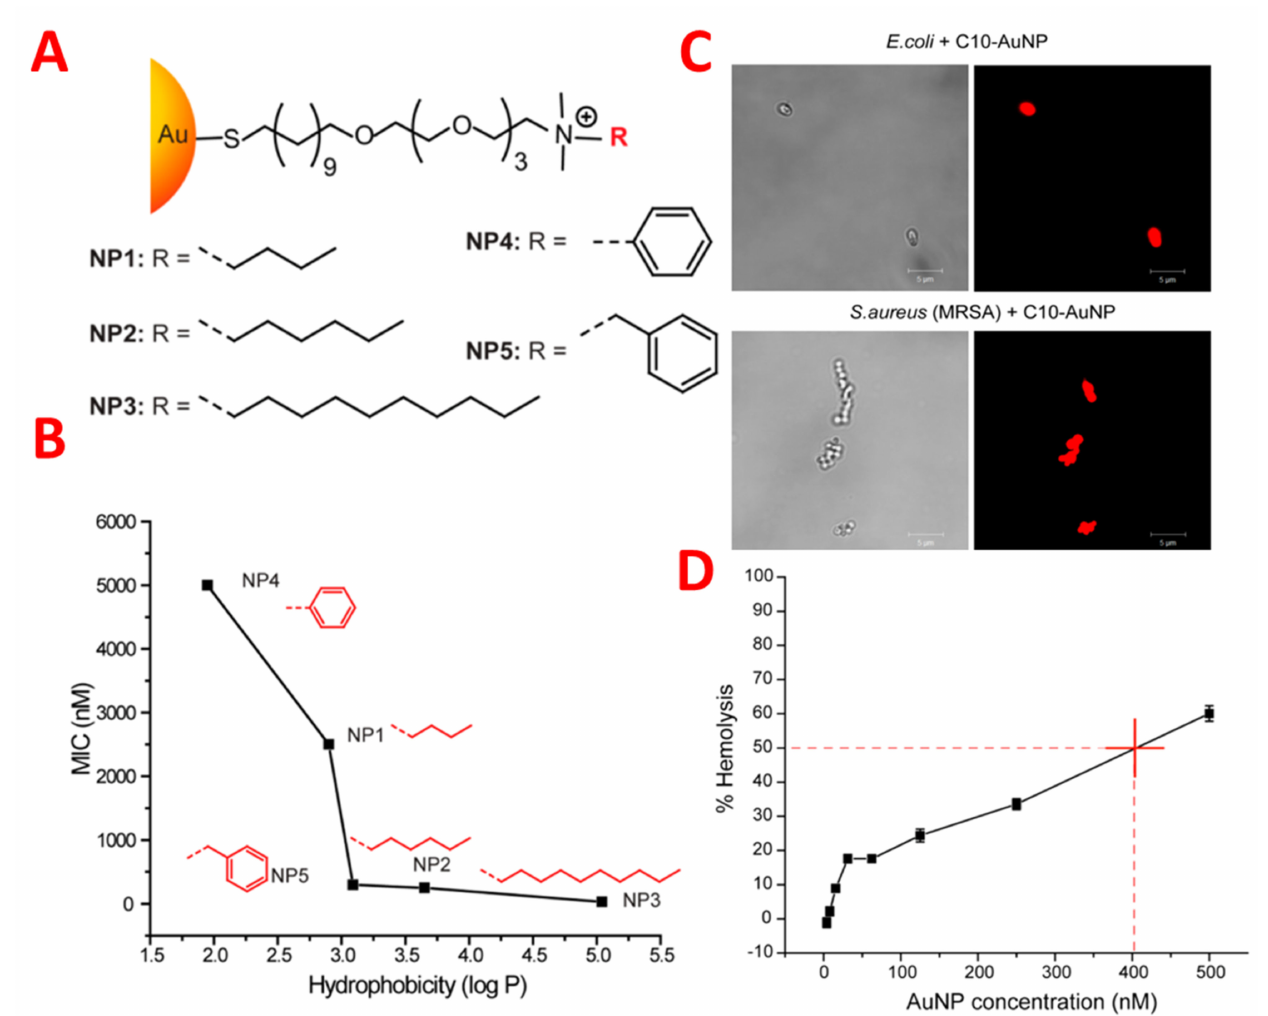
Figure 4. ( A ) Molecular structures of functional ligands on AuNPs. ( B ) MIC values (nM) of AuNPs bearing different hydrophobic surface ligands against laboratory E. coli DH5R. Log P represents the calculated hydrophobic values of the end groups. ( C ) PI staining showing NP 3 (C10-AuNP)-induced bacterial cell membrane damage. Scale bar is 5 µ m. ( D ) Hemolytic activity of NP 3 at different concentrations. HC50 was estimated to be ∼ 400 nM (as denoted by the red cross in figure). Adapted with permission from [28], American Chemical Society,